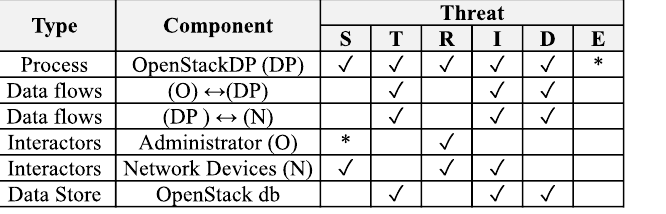
Table 13 Security analysis for the components of OpenStackDP